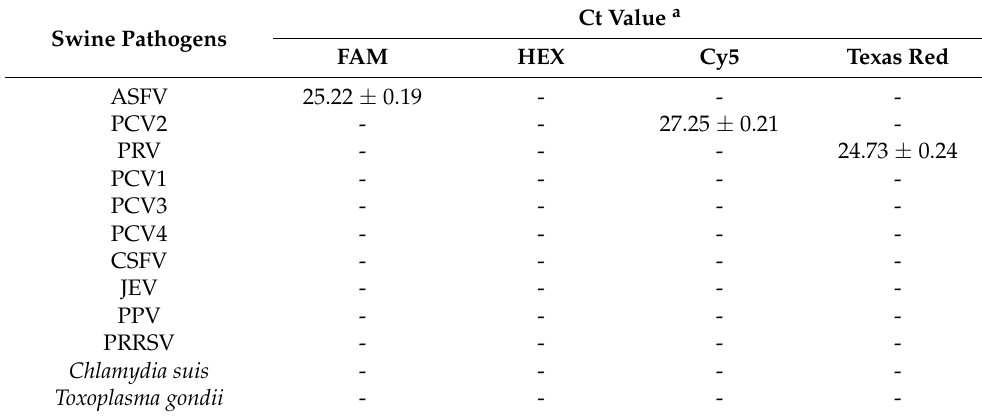
Table 3. The Ct values of the specificity tests of the multiplex real-time qPCR.